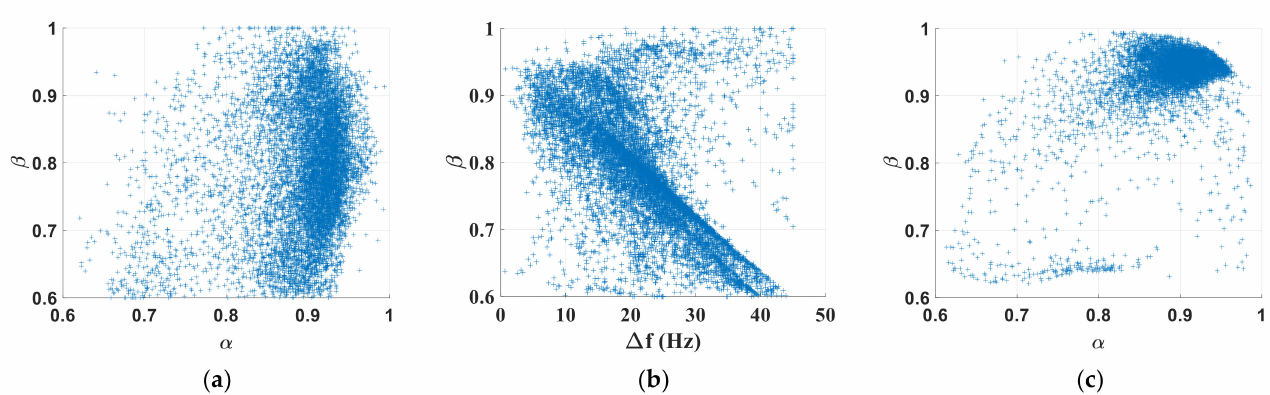
Figure 9. Scatter plots to assess time fractional Bloch equations parameter dependency in the human brain. Displayed are ( a ) the relationships between α and β for the case when ∆ f (cid:54) = 0 and ( b ) between ∆ f and β . When ∆ f = 0 is assumed, the ( c ) α − β relationship results. The ∆ f − β trend may be perceived as linear, with a negative